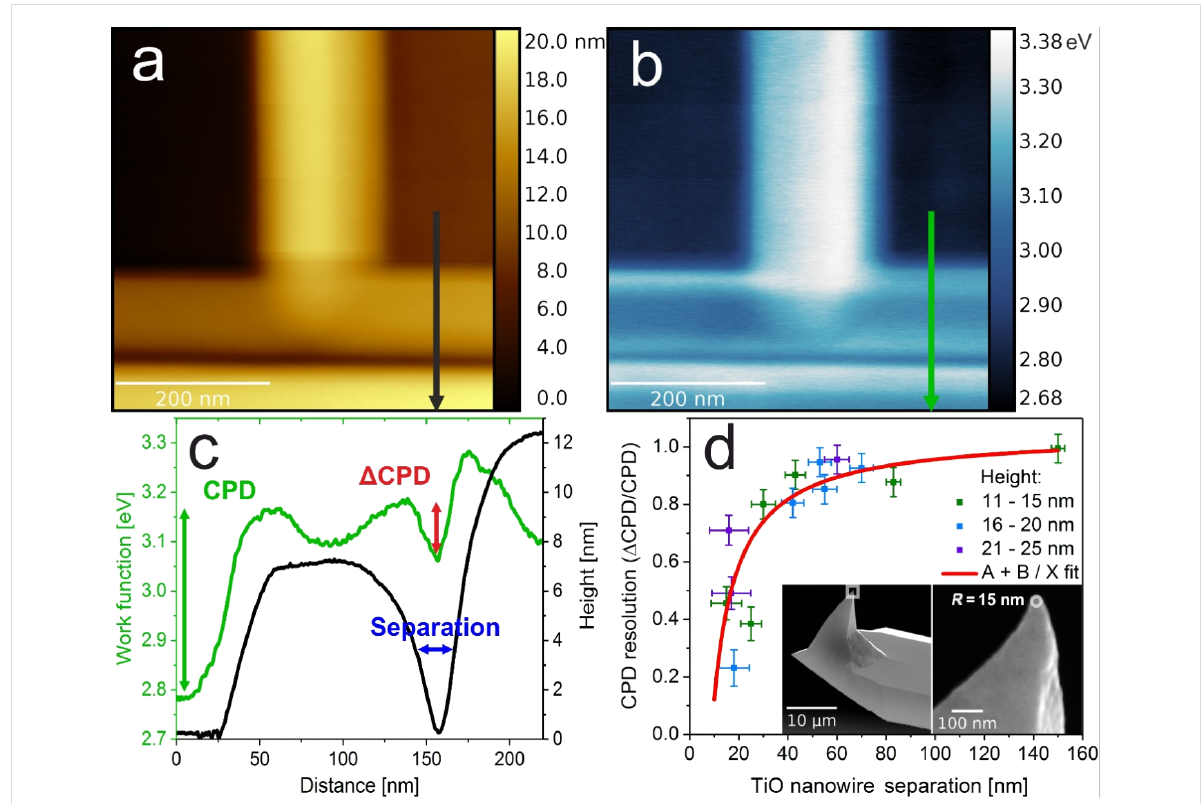
Figure 4: KPFM lateral resolution on high TiO/STO structures. a) Topography and b) work function of TiO nanowire array on SrTiO 3 (100). c) Height (black line) and work function (green line) profiles of two adjacent TiO nanowires, showing high KPFM contrast. d) Dependence of the CPD resolution (estimated as Δ CPD/CPD, see c) on the separation between TiO nanowires, with A + B/X asymptote fit. Insets show the SEM images of the actual PtSi cantilever used in the experiments with a tip radius of 15